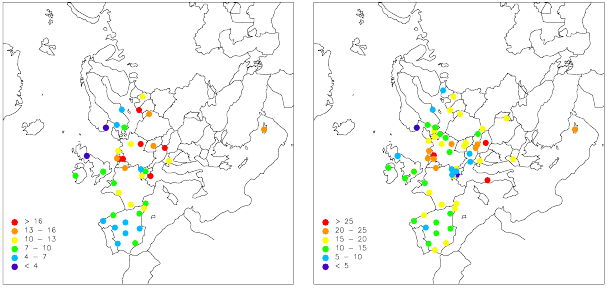
Fig. 5. Geographical distribution of PM 2 . 5 (left) and PM 10 (right) in 2009. Unit: µgm − 3